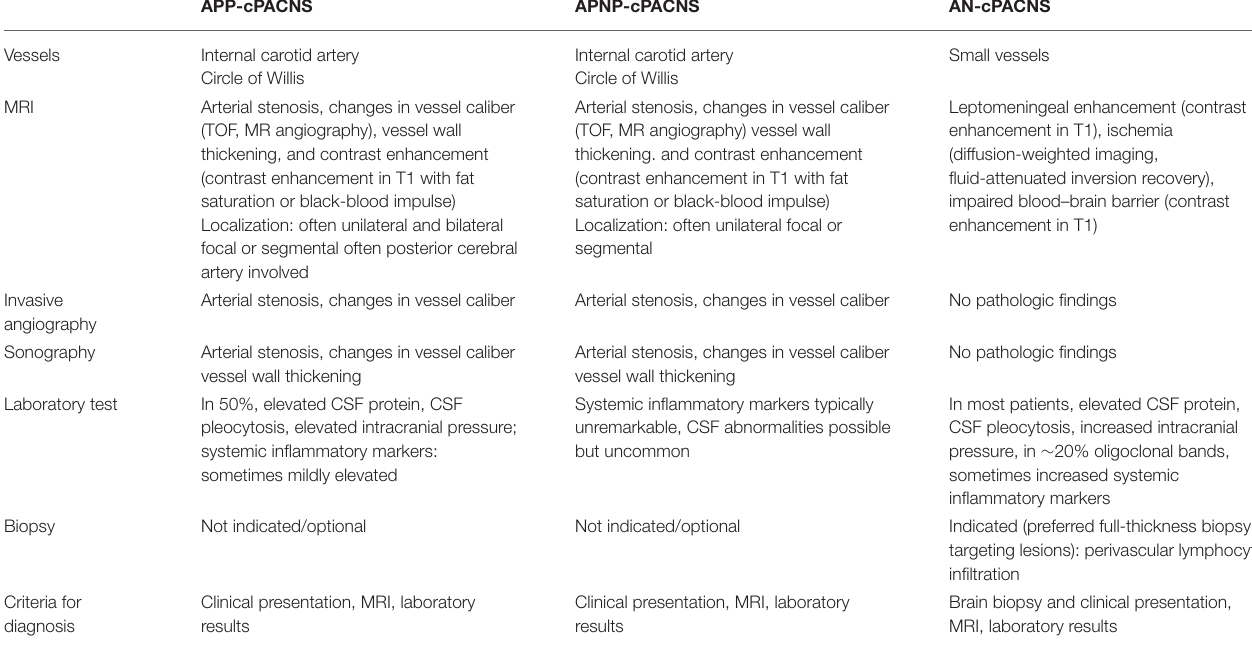
TABLE 3 | Diagnostic assessments in